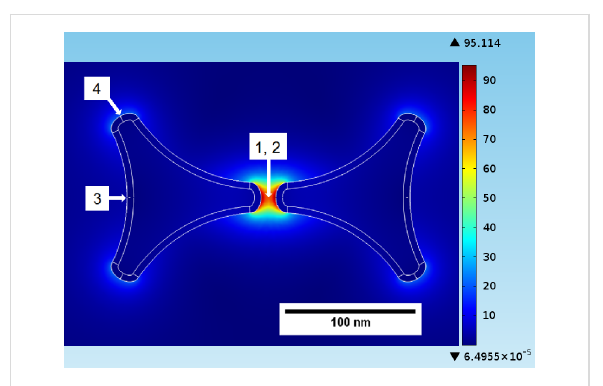
Figure 12: Field enhancement ratio (scale goes from 0 to 90) for Ag bow-tie nano-antennas with tip-to-edge length of 100 nm, thickness 30 nm, and gap size of 12 nm under excitation at 700 nm. The labels 1 to 4 mark the positions for which the field-enhancement curves shown in Figure 11 were calculated.